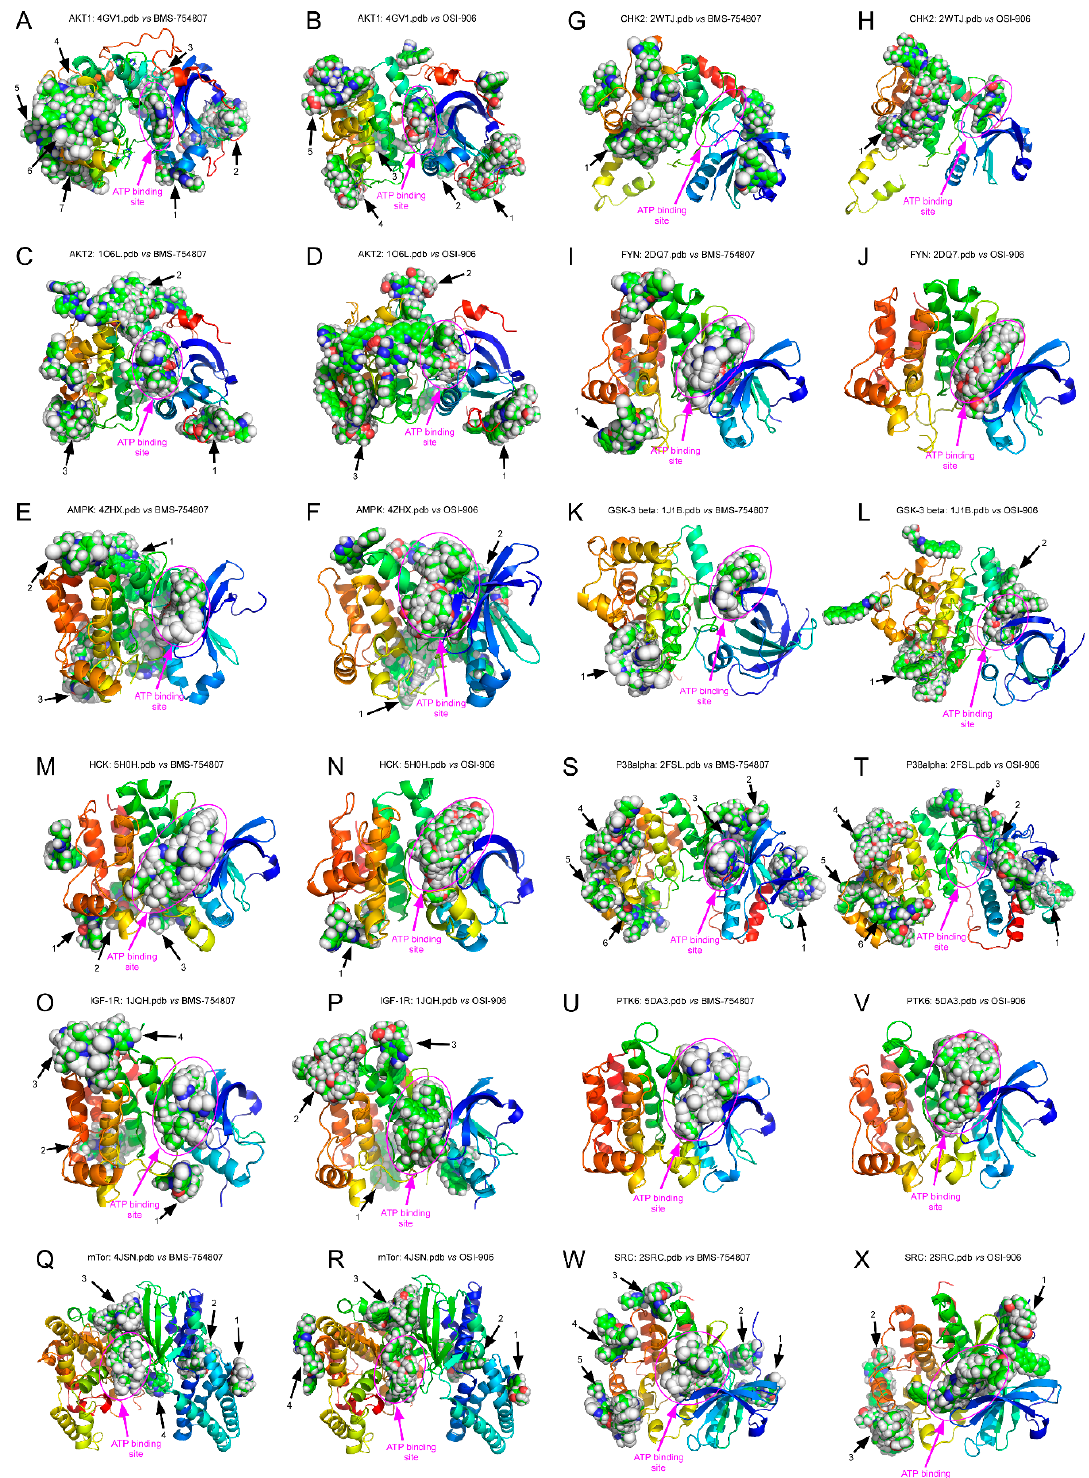
Figure 8. Molecular docking of BMS-754807 and OSI-906 binding to the full catalytic domain of several protein kinases. In each panel, the catalytic domain of each indicated protein kinase was represented by its amino acid backbone as a colored cartoon in the rainbow range from N-terminal ( blue ) to C-terminal ( red ). A pink ellipse delineates the ATP-binding site, and the ligand molecules are represented by Van der Waals spheres. Numbered black arrows for each ligand-protein kinase binding area (cluster), different from the ATP-binding site, are also indicated.